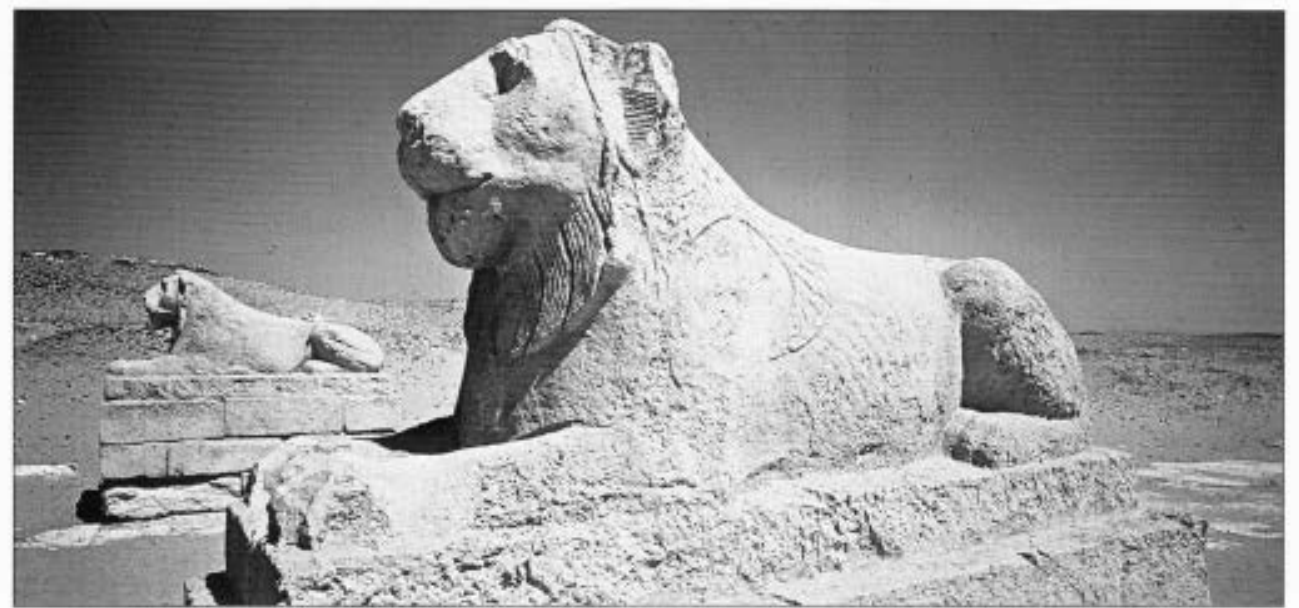
Figure 4 A pair of limestone lions guarding the northern end of the processional way leading to the temple ofSoknebtunis at Tebtunis.